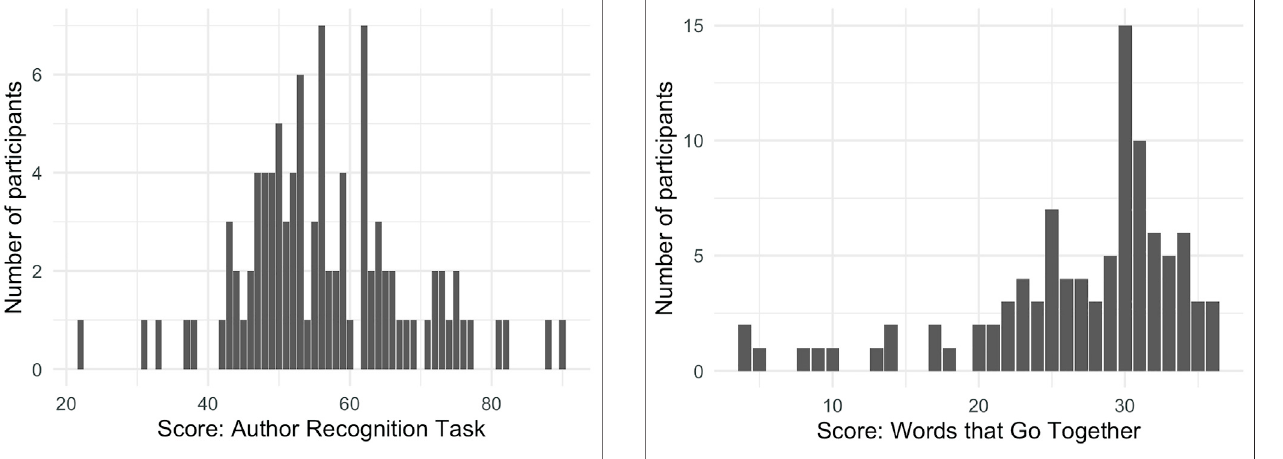
FIGURE 5 | Distribution of scores on the Author Recognition task. FIGURE 6 | Distribution of scores on the Words that Go Together task.